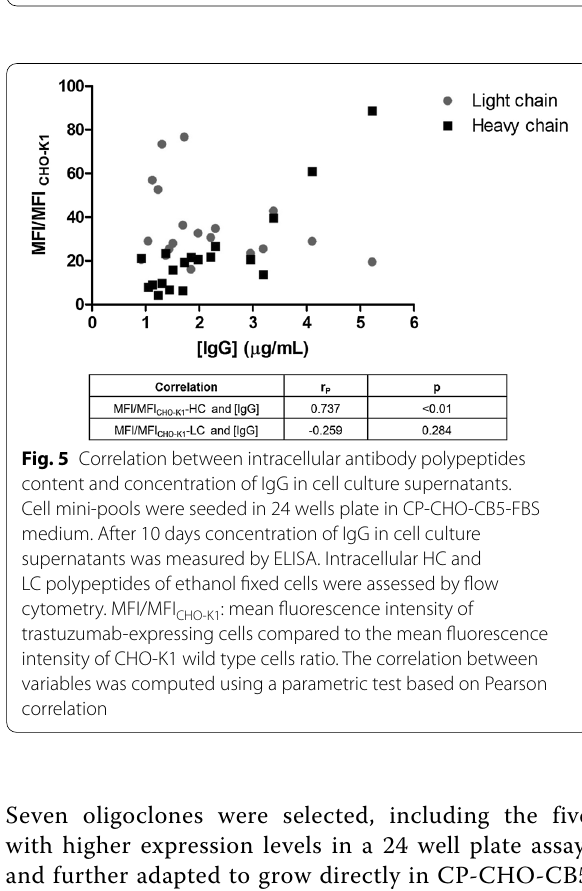
SD. The discontinuous line ±